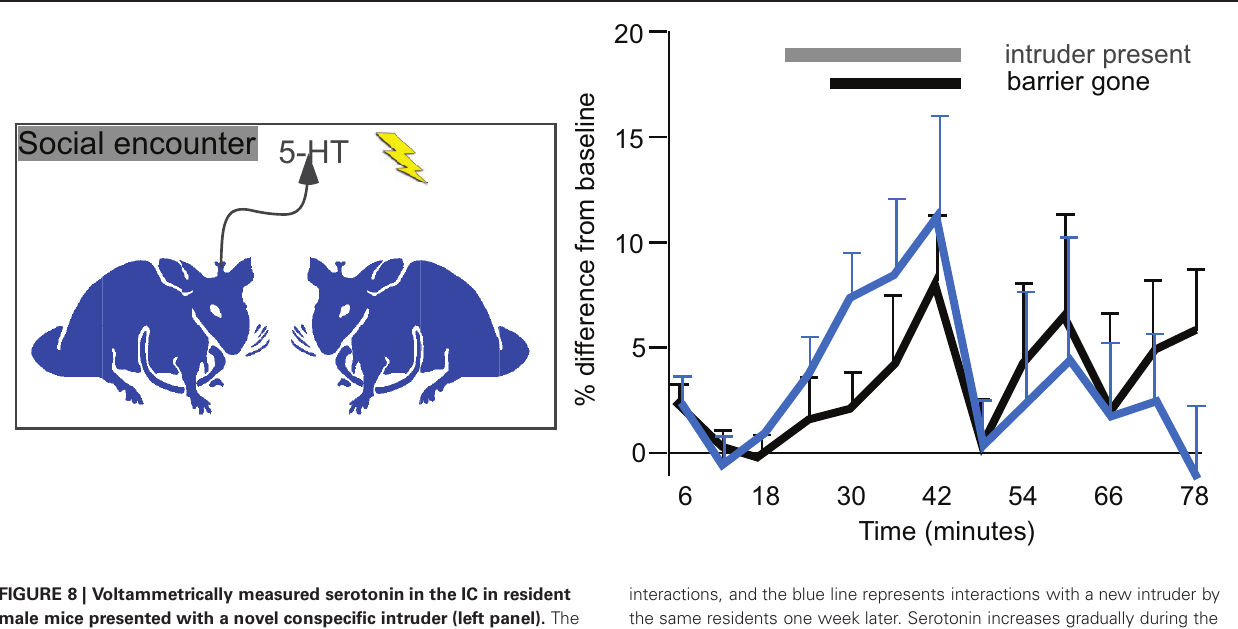
FIGURE 8 | Voltammetrically measured serotonin in the IC in resident male mice presented with a novel conspecific intruder (left panel). The right panel plots changes in serotonin over baseline measurements. The gray bar represents time in which an intruder male was placed in the cage of a resident. The black bar represents time in which a Plexiglass barrier was removed and males directly interacted. The black line represents the initial